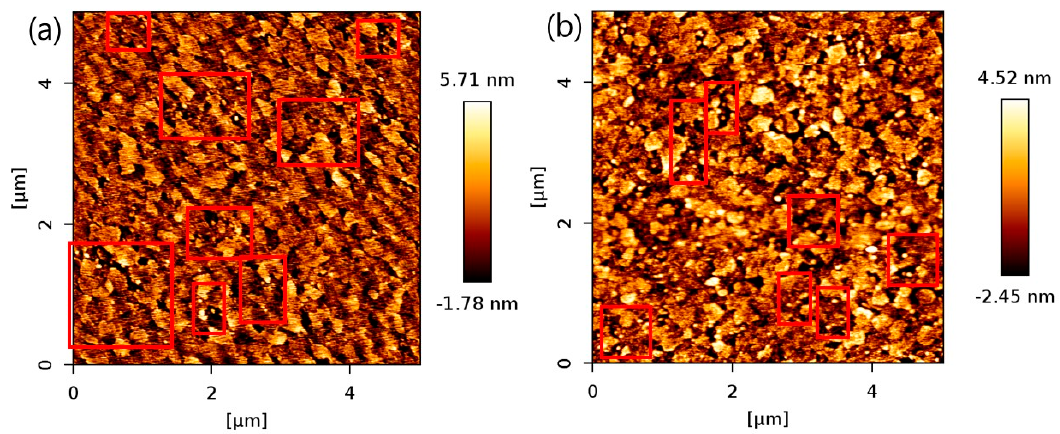
Figure 5. Atomic Force Microscopy (AFM) topographic data of QD arrays onto ITO surface for ( a ) yellow QDs; and ( b ) green QDs. The high-contrast spots in the red open boxes exhibit QDs.